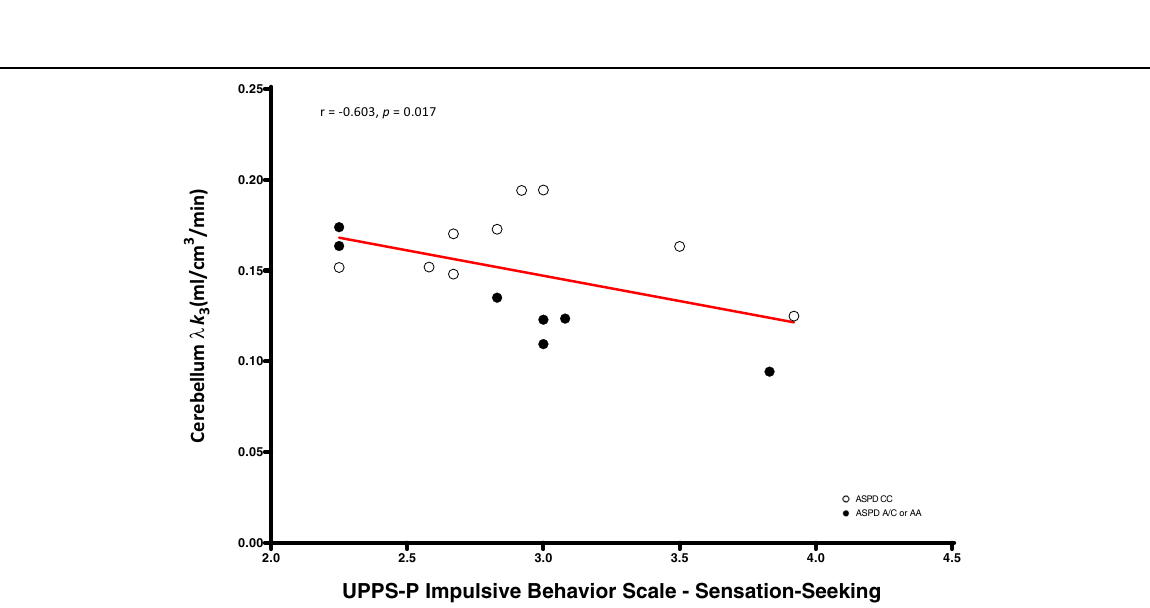
Fig. 2 Cerebellum fatty acid amide hydrolase λ k 3 is negatively correlated with UPPS-P Impulsive Behavior Scale — sensation-seeking in antisocial personality disorder. After controlling for genotype, antisocial personality disorder participants with lower cerebellar fatty acid amide hydrolase density endorsed greater sensation-seeking impulsivity.